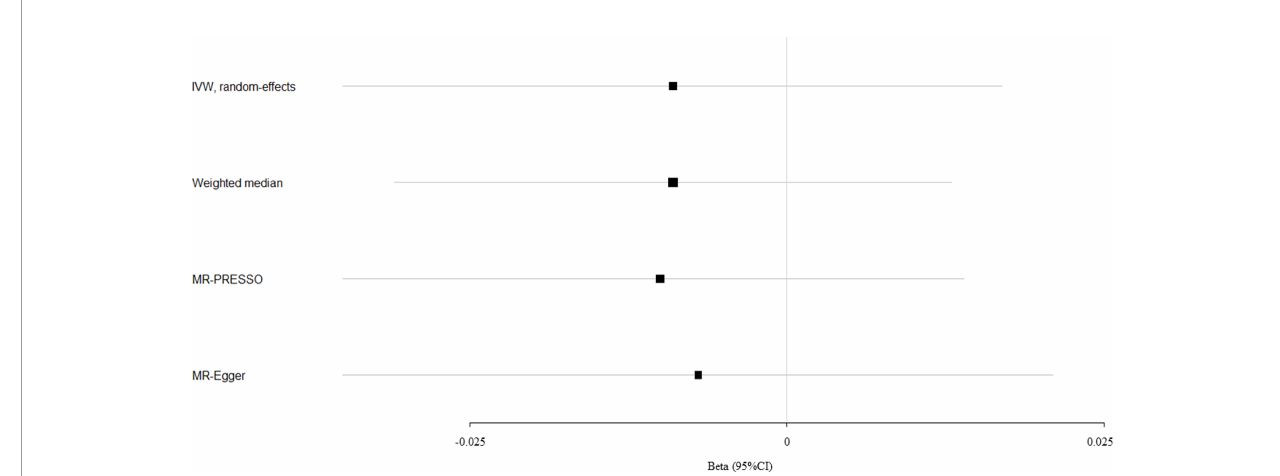
FIGURE 2 | Mendelian randomization analysis for the association between circulating bilirubin levels and fracture.